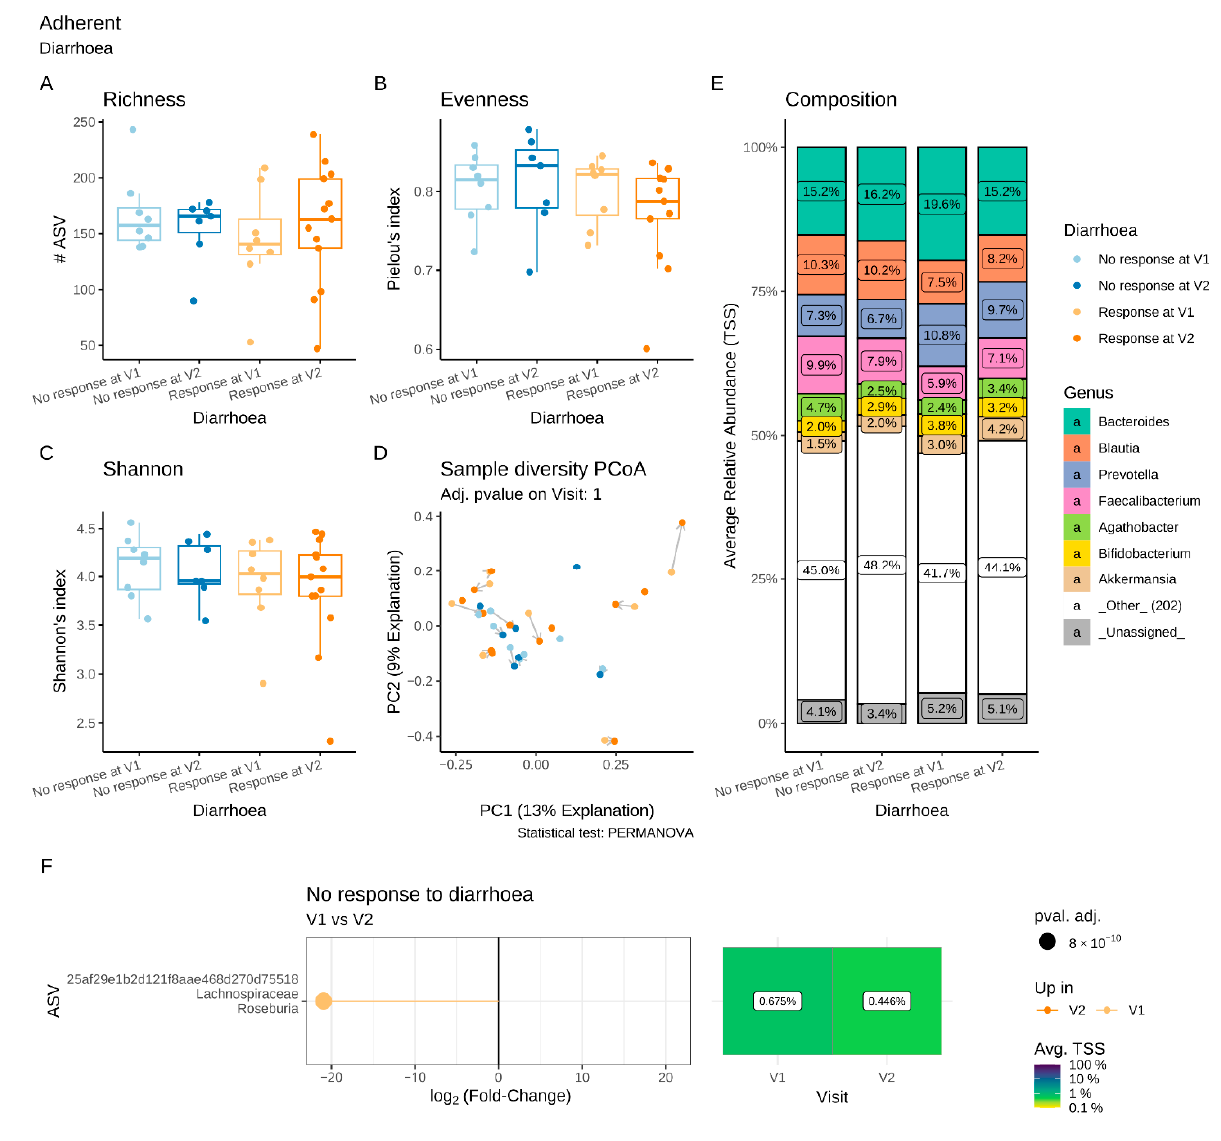
Figure 9. Impact of a 4-week supplementation with the multistrain probiotic on the adherent gut microbiota in Diarrhoea responders (R) and non-responders (NR). ( A – C ) α -diversity, estimated by the richness (number of observed ASVs) ( A ), evenness (Pielou’s index) ( B ) and Shannon’s index ( C ); ( D ) principal coordinate analysis (PCoA) of bacterial β -diversity, measured according to the Bray–Curtis distance; ( E ) bacterial taxonomic profile at the genus level before (V1) and after (V2) supplementation; ( F ) differential abundance analysis at ASV levels at V1 and V2 in Diarrhoea NR. Only significant data are presented as Log2 of the fold of change (FC) according to DESeq2 analysis. Transcription start sites (TSS)